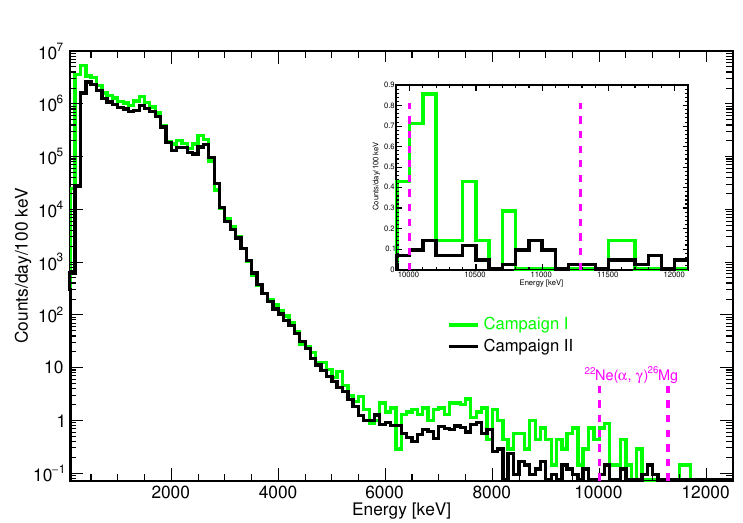
Figure 3: Laboratory background taken during Campaign I (green line) and Campaign II (black line). The dashed magenta lines define the ROI for the 395 keV resonance.